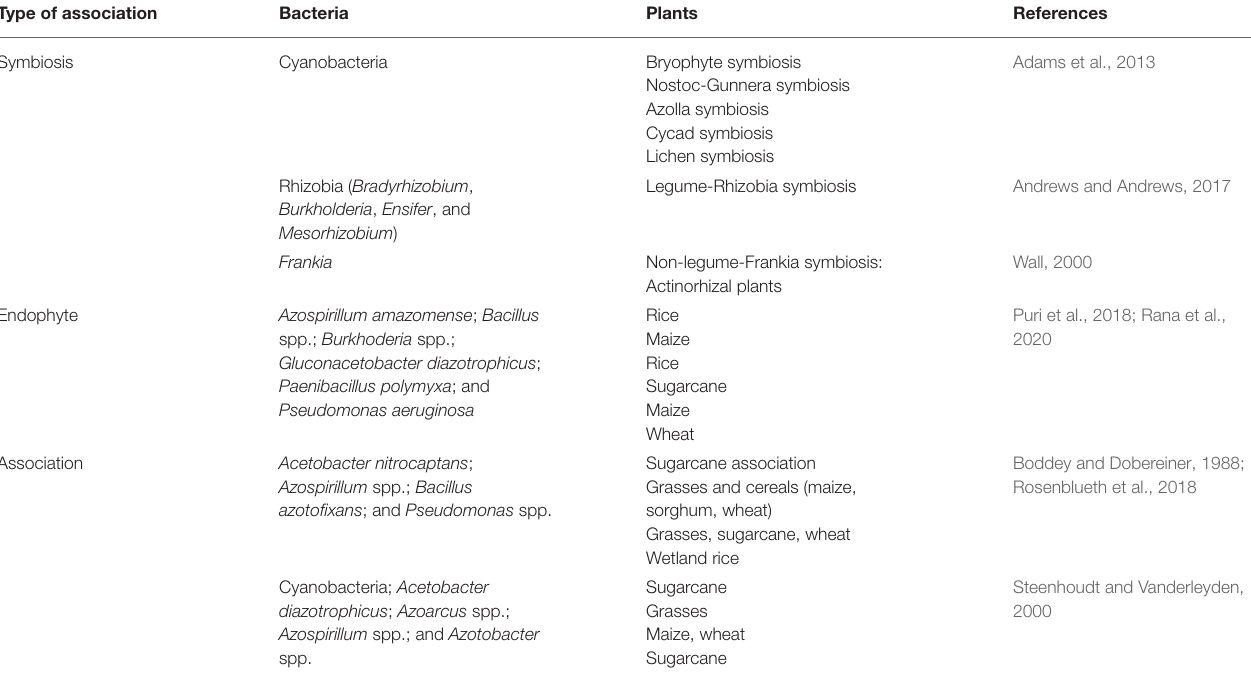
TABLE 2 | Representative nitrogen fixing